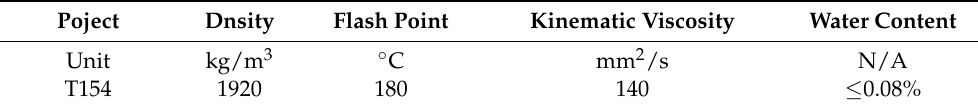
Table 3. Properties of T154 polyisobutene–diene imide raw